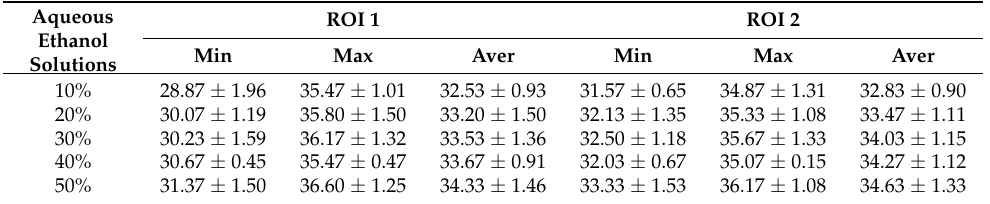
Table 3. Tongue surface temperatures after treated with aqueous ethanol solutions ( n = 3).